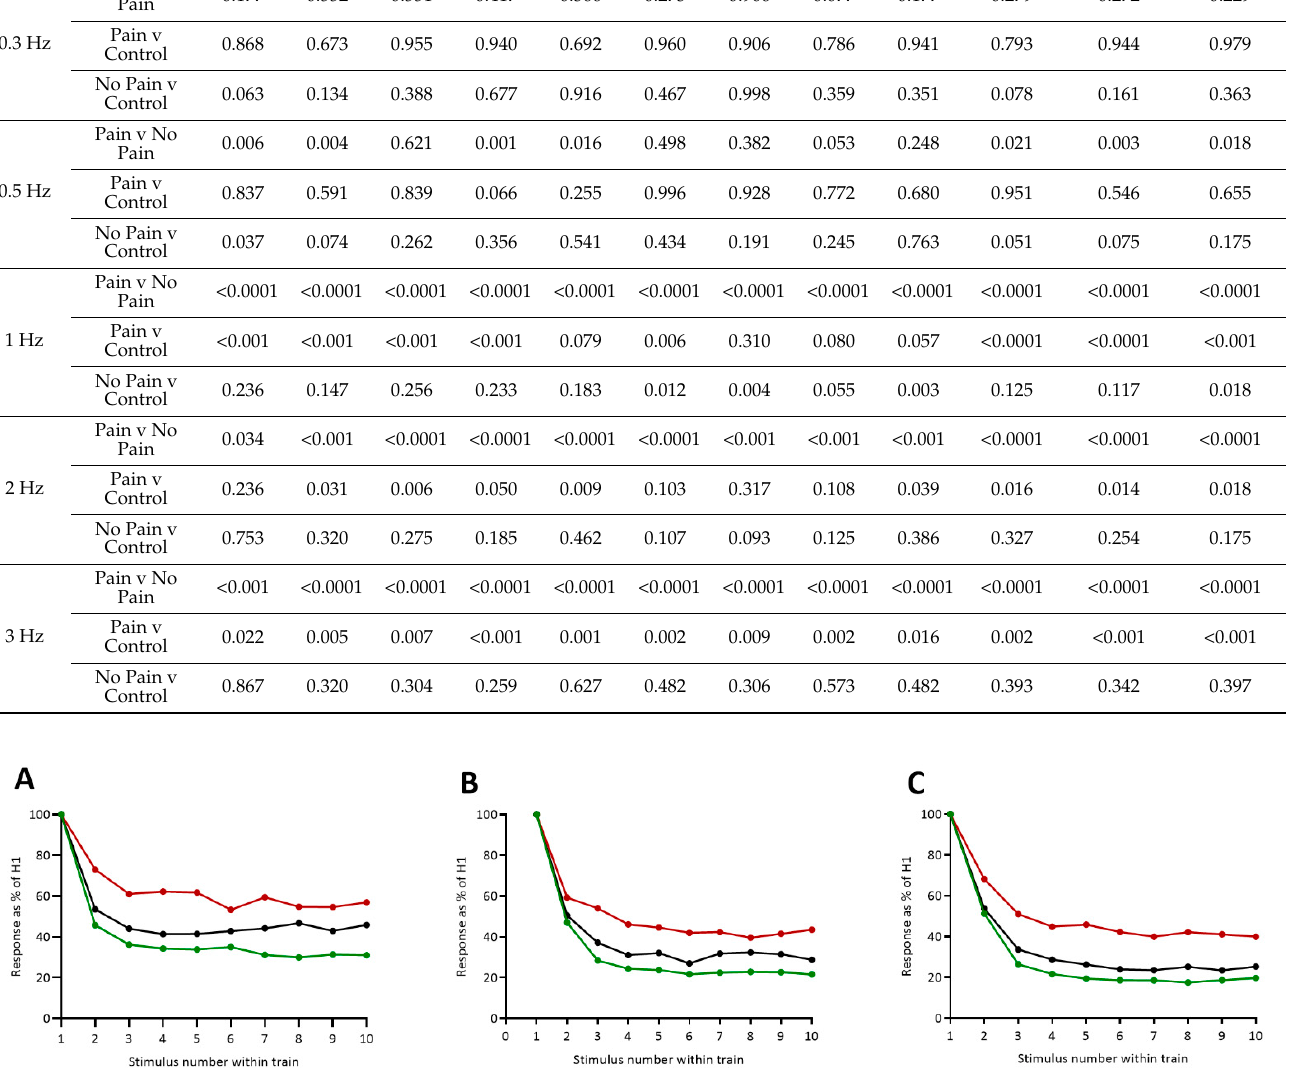
Figure 2. Group mean H wave amplitude responses to stimulus train at ( A ) 1 Hz, ( B ) 2 Hz and ( C ) 3 Hz in control subjects